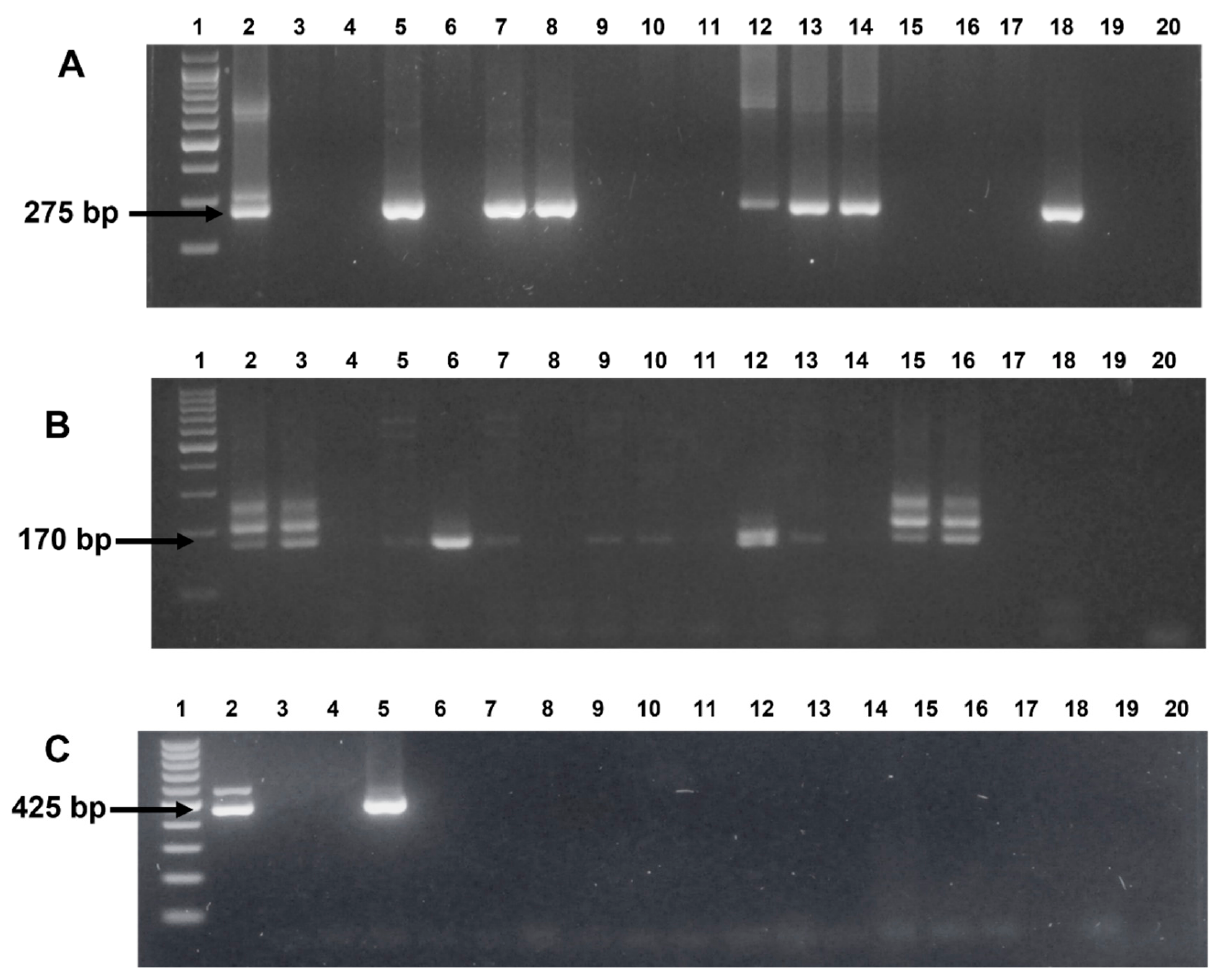
Figure 1. Representative image of nested PCR-amplified products using primers specific for ( A ) Babesia bovis . Lanes: 1, molecular marker 100 bp; 2, Positive bovine control; 3, Negative bovine control; 4–18, Buffalo samples; 19–20, Nuclease-free water control. ( B ) Babesia bigemina . Lanes: 1, molecular marker 100 bp; 2–3, Positive bovine controls; 4–16, Buffalo samples; 17, Negative bovine control; 18 and 20, Nuclease-free water control; 19, empty. ( C ) Anaplasma marginale . Lanes: 1, molecular marker 100 bp; 2, Positive bovine control; 3, Negative bovine control; 4, Nuclease-free water control; 5–17, Buffalo samples; 18, empty; 19–20, Nuclease-free water controls. Table 2. nPCR detection of B. bovis , B. bigemina , and A. marginale in water buffaloes from